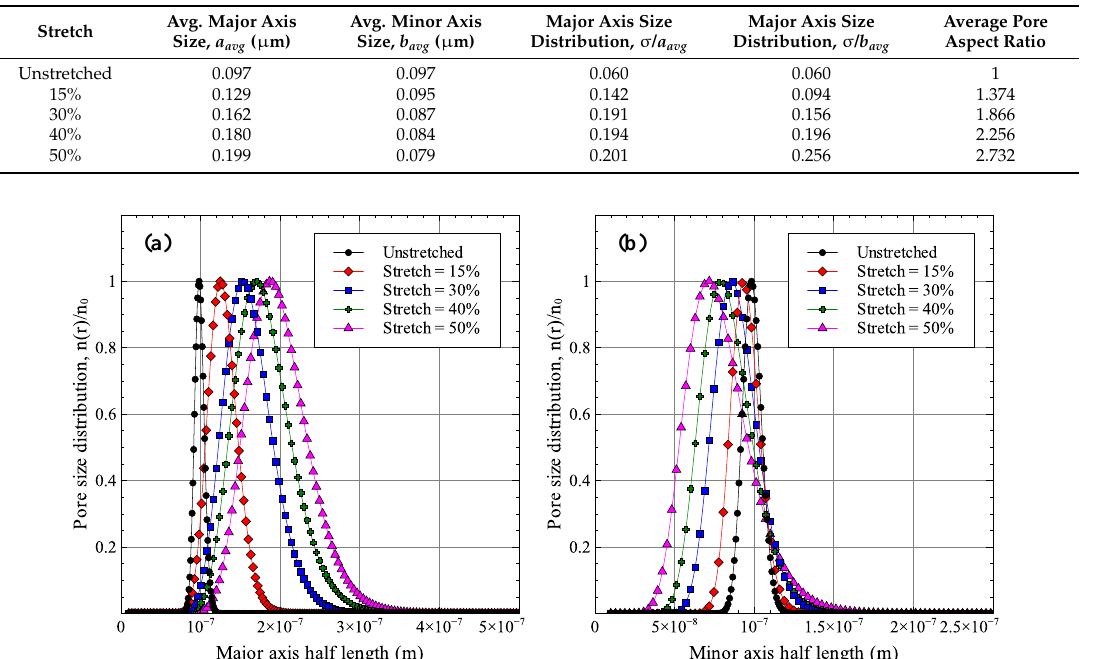
Figure 7. ( a ) Major and ( b ) minor axes size distribution for stretched membranes.